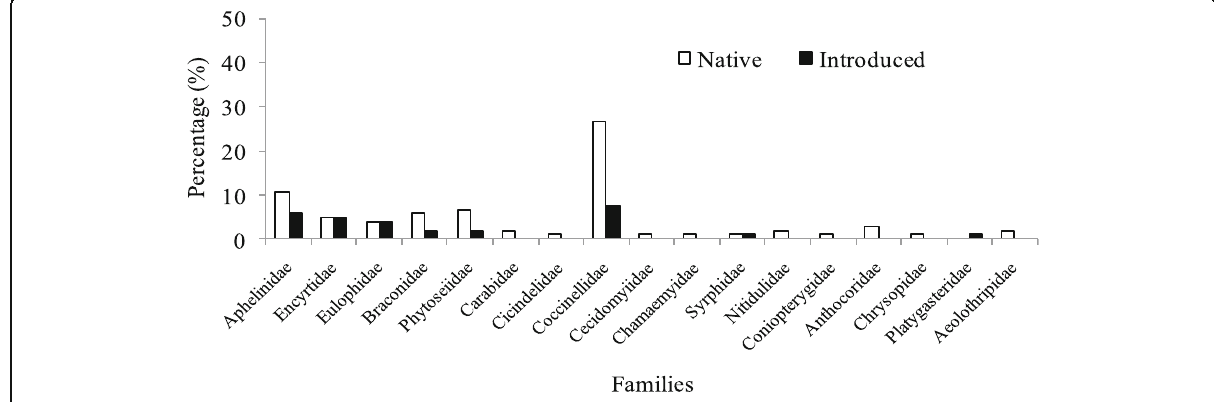
Fig. 1 Percentage of presence (%) of beneficial species grouped by families in Moroccan citrus orchards ( N = 105)